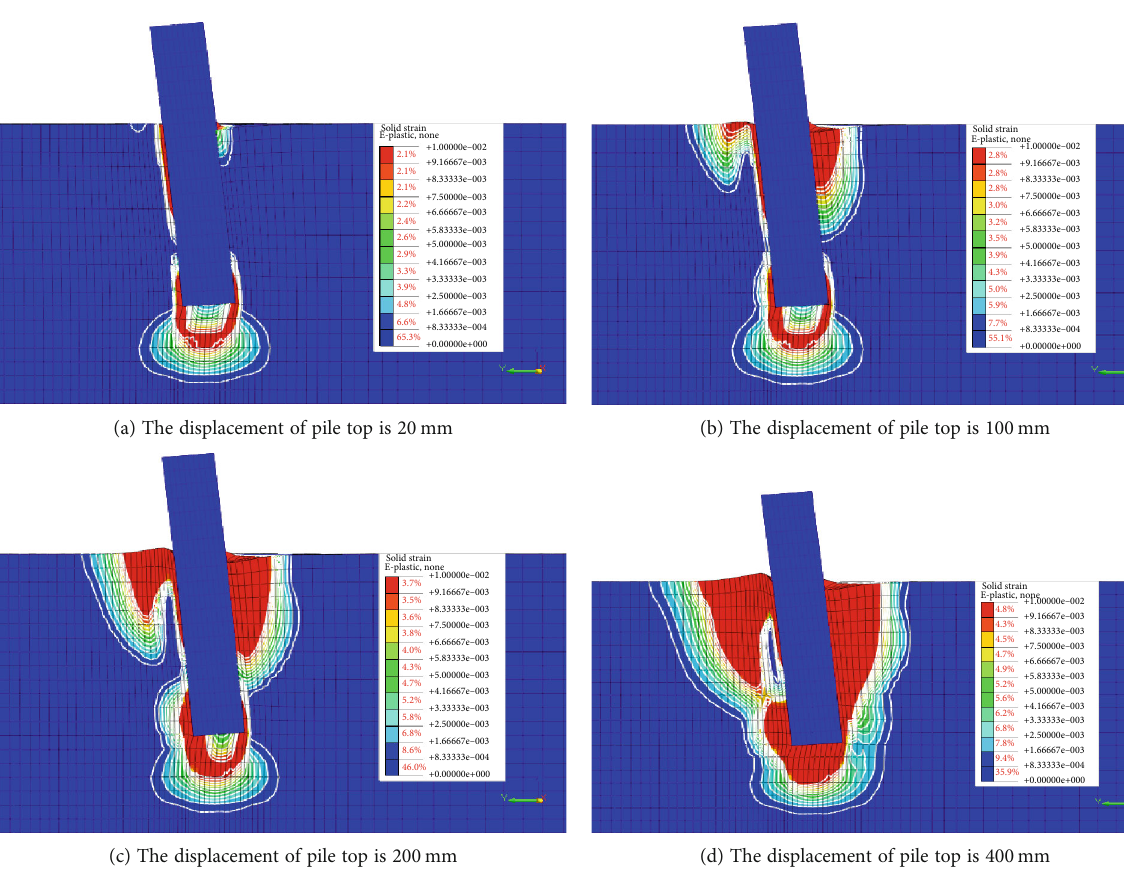
Figure 14: Plastic division layout of vertical pro fi le of soil around pile. Table 3: Similarity ratio of model